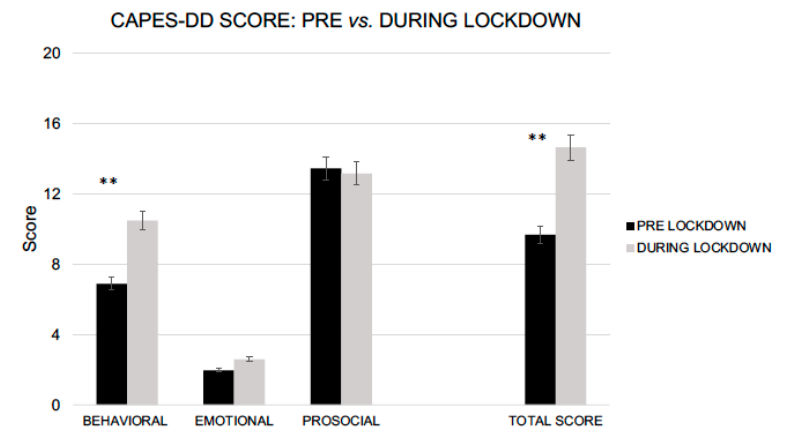
Figure 1. CAPES-DD scores between pre and during lockdown (** p > 0.01). Although mothers reported higher children’s behavioral problems, their self-efficacy in managing these problems remained stable between pre- (Self-Efficacy Scale, pre-lockdown, M M score = 104.39, SD score = 45.06) and during lockdown ( M score = 105.59, SD score = 41.66), t 52 = 0.264, p = 0.793.